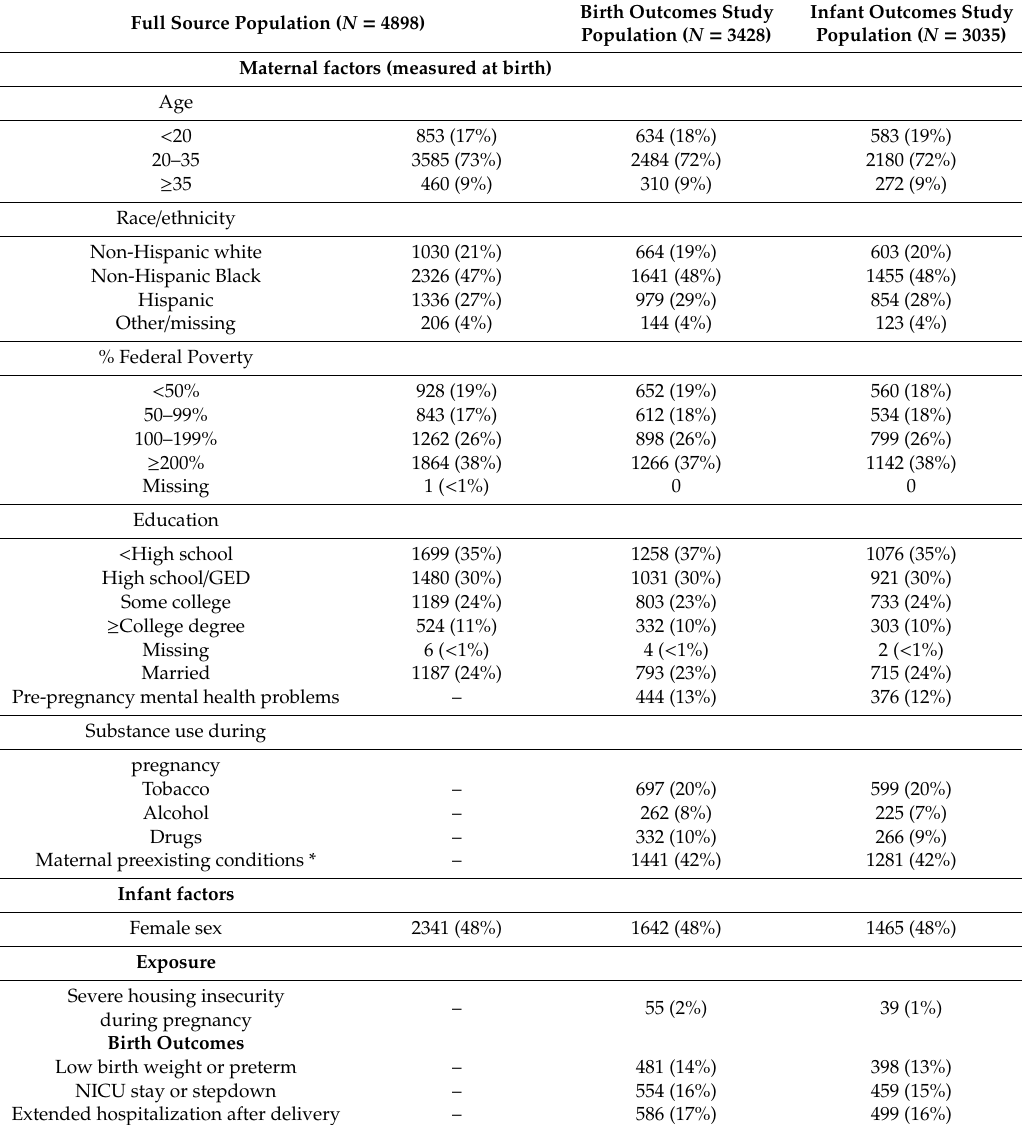
Table A1. Characteristics of mothers and infants in the source population (i.e., the full Fragile Families and Child Wellbeing baseline sample), the birth outcomes study population, and the infant outcomes study